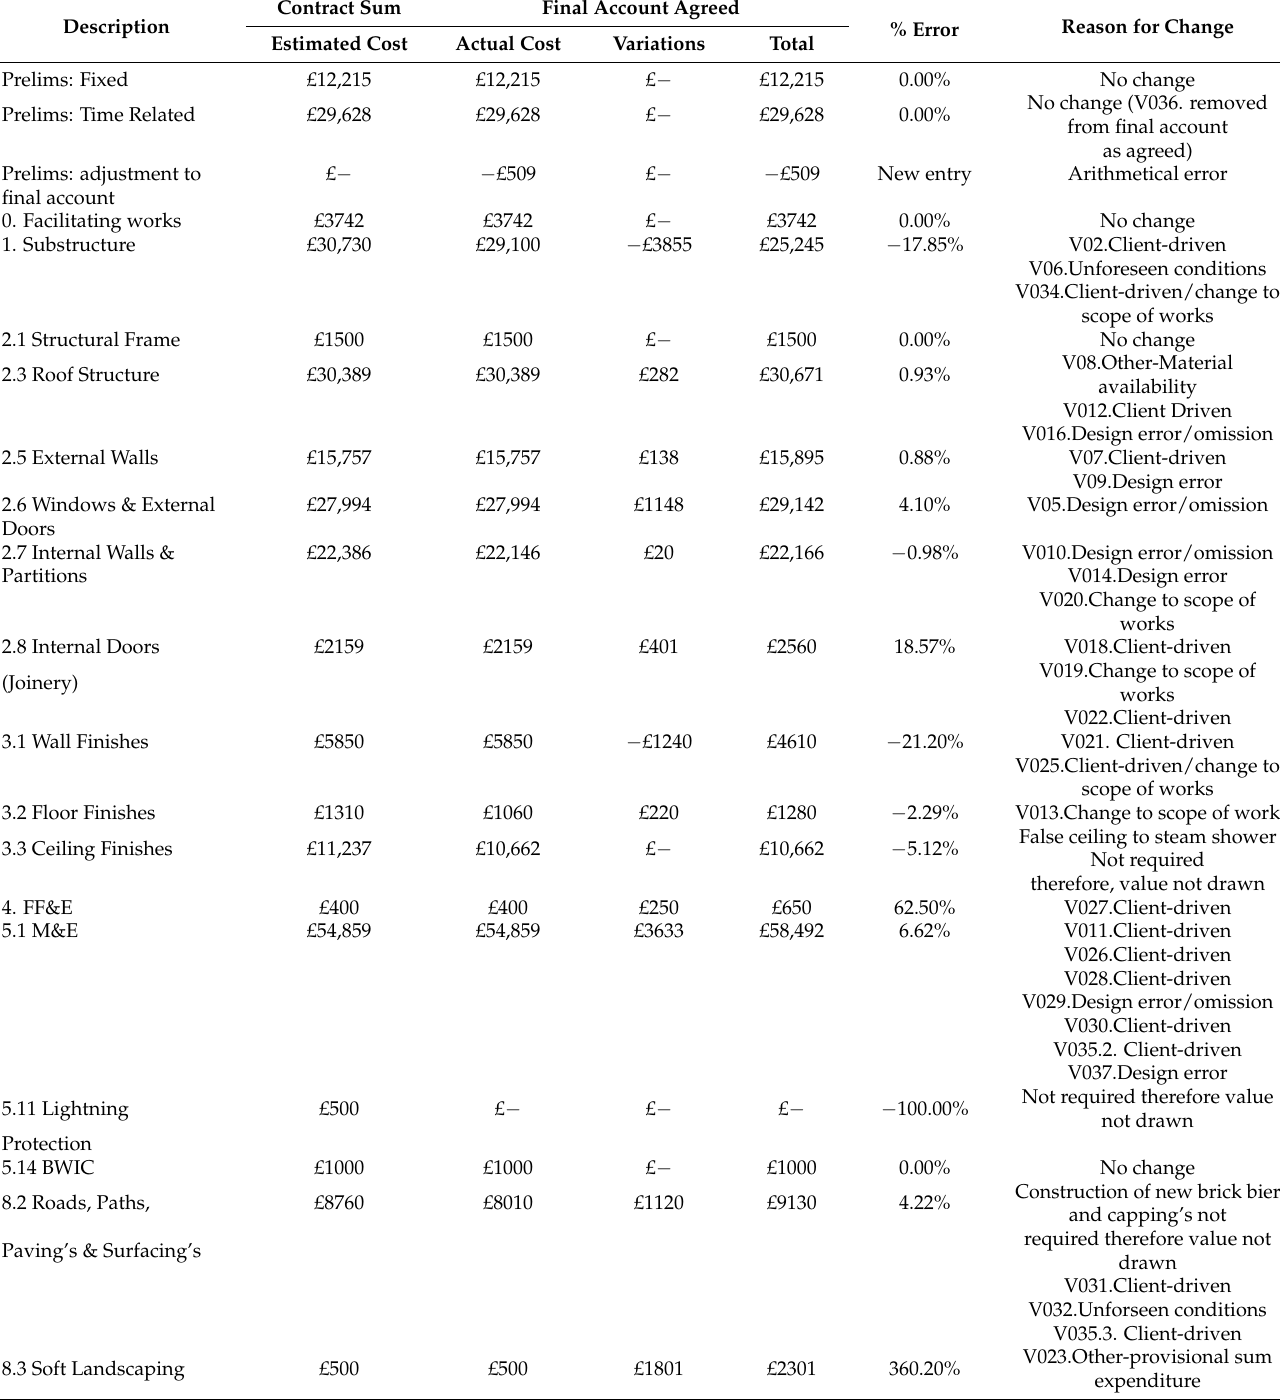
Table 5. Cross-sectional time